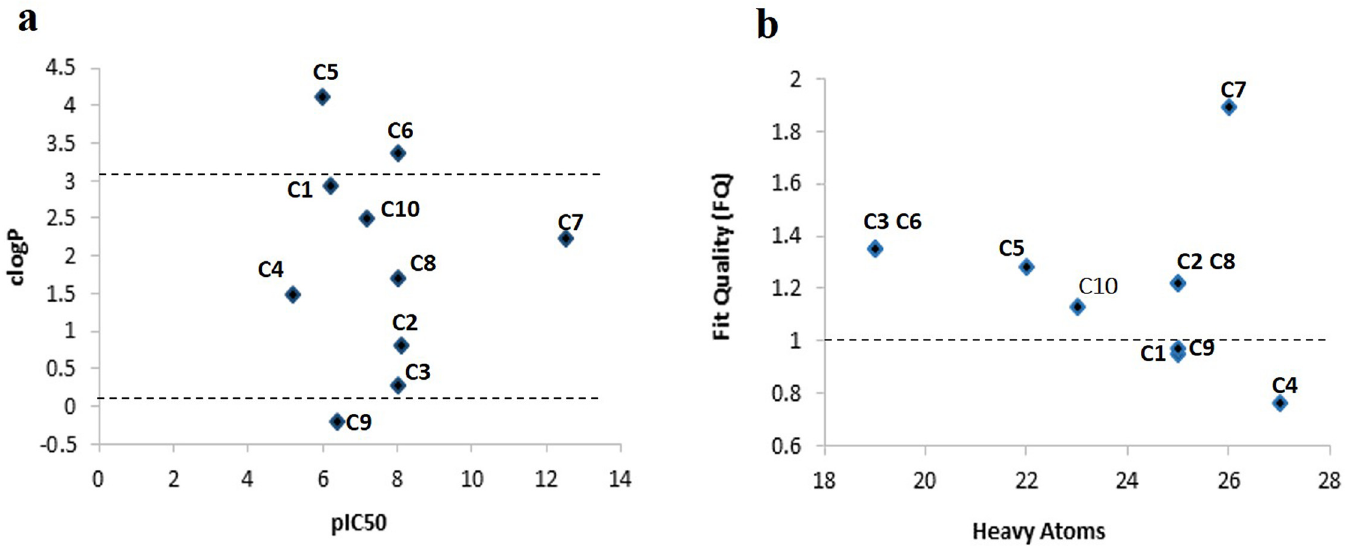
Fig 6. Ligand efficiency analysis of 10 selected compounds (C1-C10). (a) ClogP and (b) Fit Quality graph.